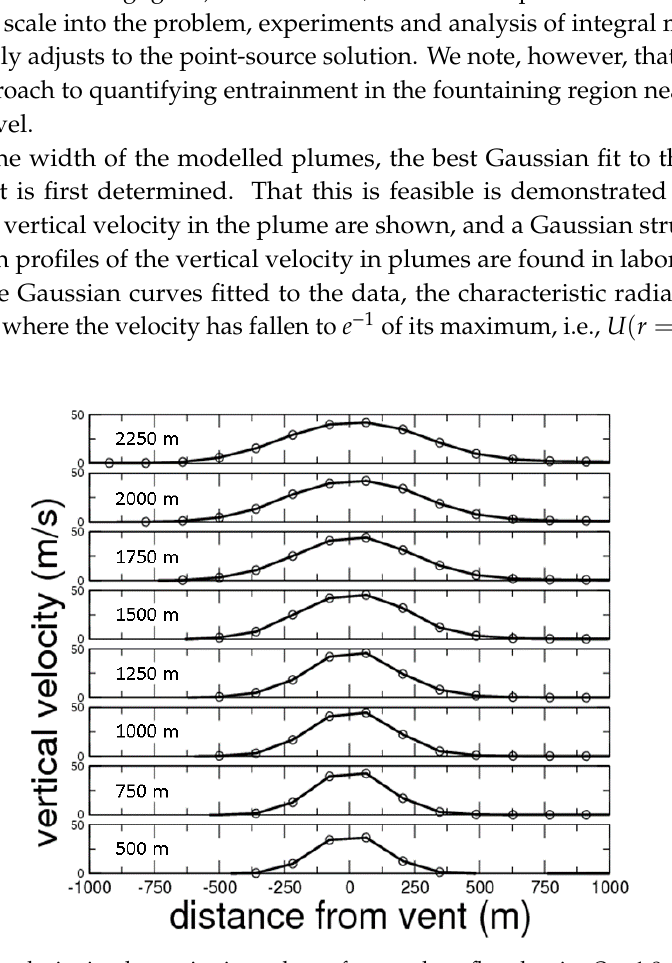
Figure 5. Vertical velocity in plume ejection column for vent heat flux density Q = 1.8 × 10 6 W m − 2 , 30 min after eruption. Individual panels represent various heights above ground (denoted in each panel).